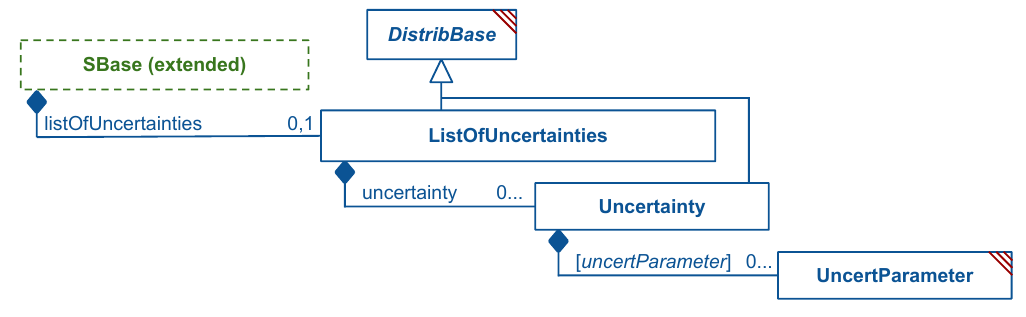
Figure 2: The definition of the extended SBase class to include a new optional ListOfUncertainties child element. Intended for use with any element with mathematical meaning, or with a Math child element. Also defines the ListOfUncertainties and Uncertainty